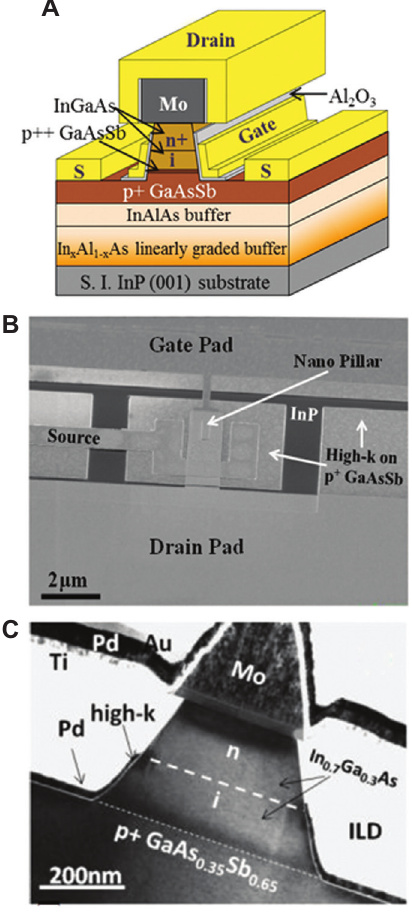
Sb /In Ga As p + -i-n + 0.35 0.65 0.7 0.3 Sb /In Ga As 0.35 0.65 0.7 0.3